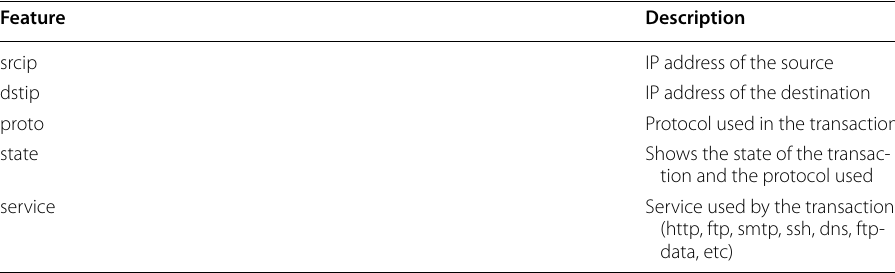
Table 3 Features with nominal data type incompatible with ML techniques Feature